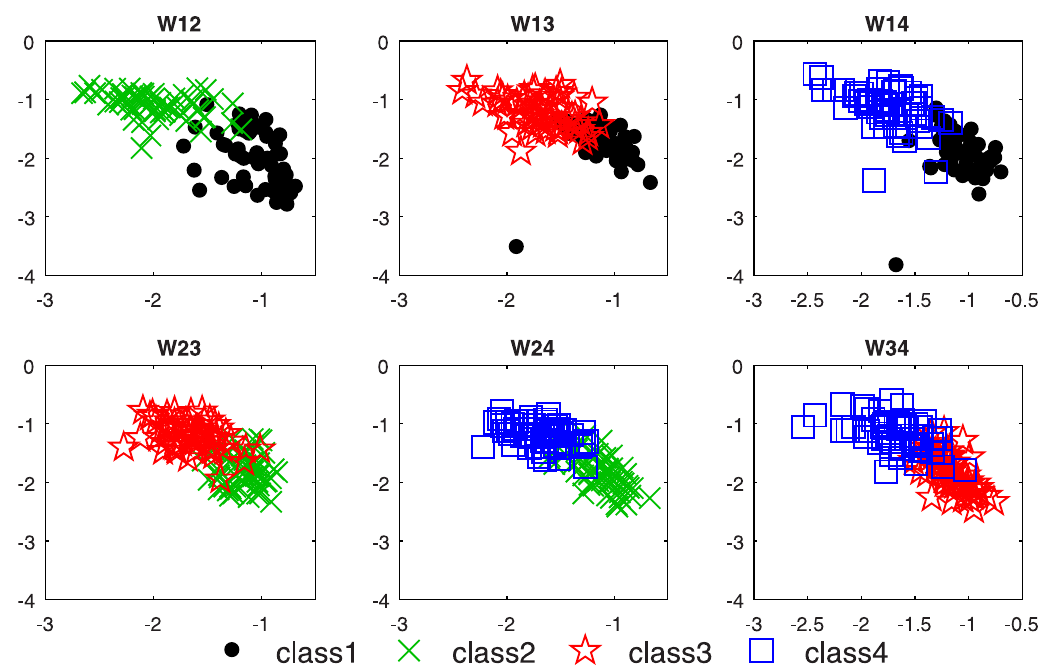
Fig 9. The distribution of most significant feature vector pairs obtained by